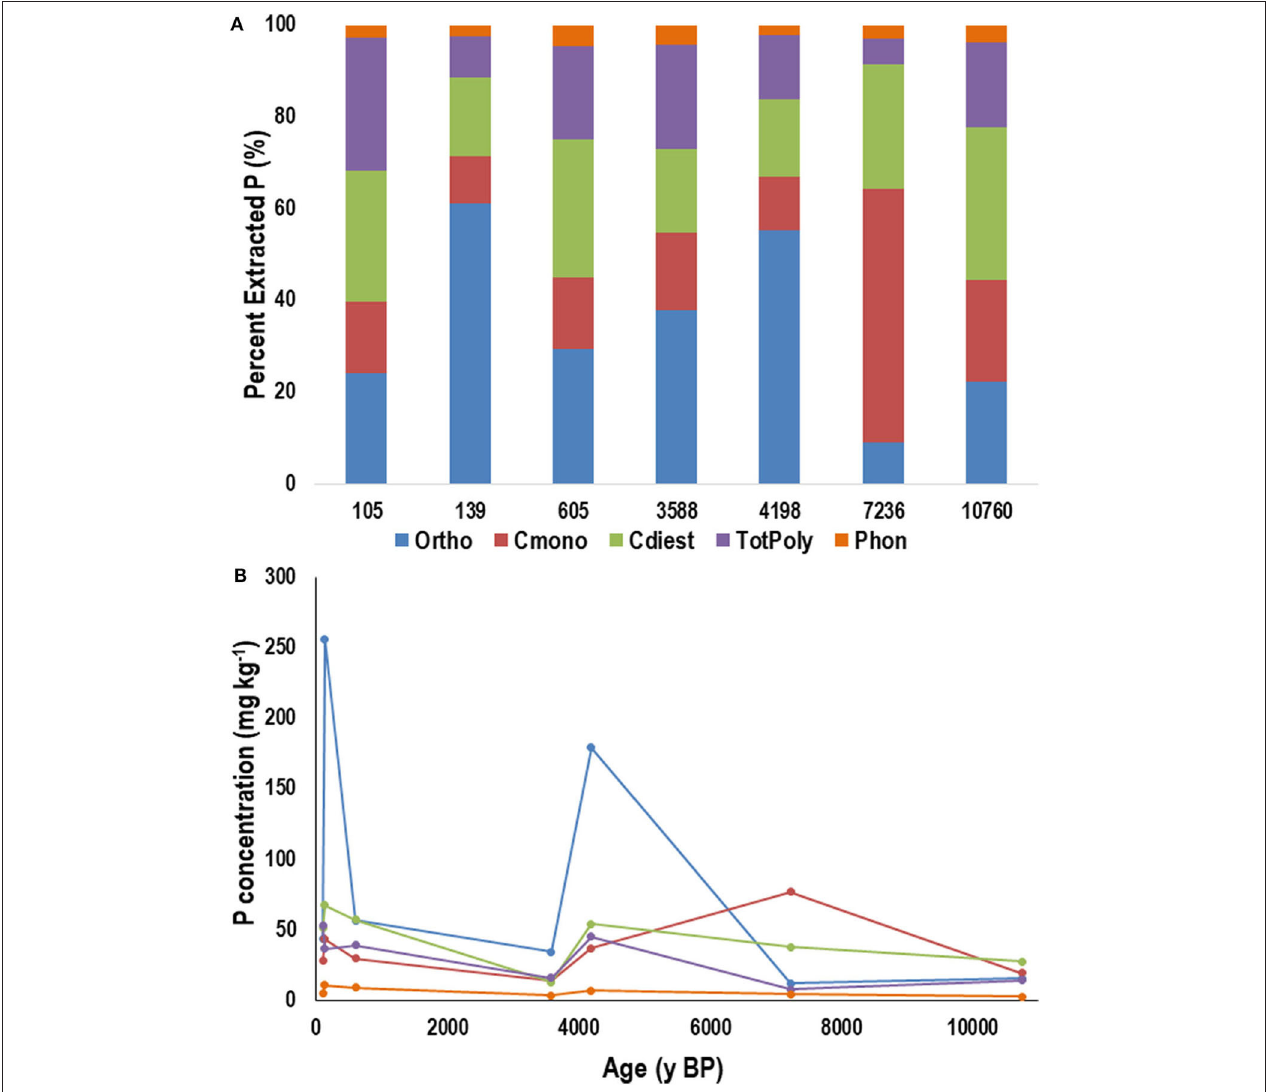
FIGURE 7 | Average proportion (A) and concentration (B) of phosphorus (P) in NaOH-EDTA extracts analyzed by P-NMR for the main groupings of P compounds in the humic-enriched organic (H) horizon from the Calvert Island chronosequence. Ortho, orthophosphate; Cmono, Cdi, orthophosphate monoesters and corrected for degradation during analysis; totPoly, total polyphosphates; Phon, phosphonates. Values are means; n =